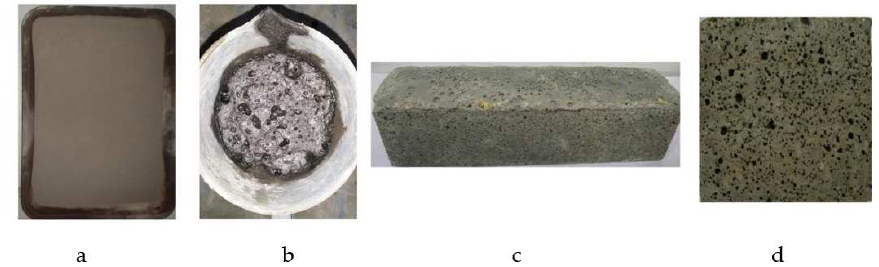
Figure 2. Examples of light materials prepared using BA. ( a ) BA after pretreatment, ( b ) Foams and expansion phenomenon, ( c ) Appearance of specimen LYY-9, and ( d ) Surface pore morphology of specimen LYY-9.